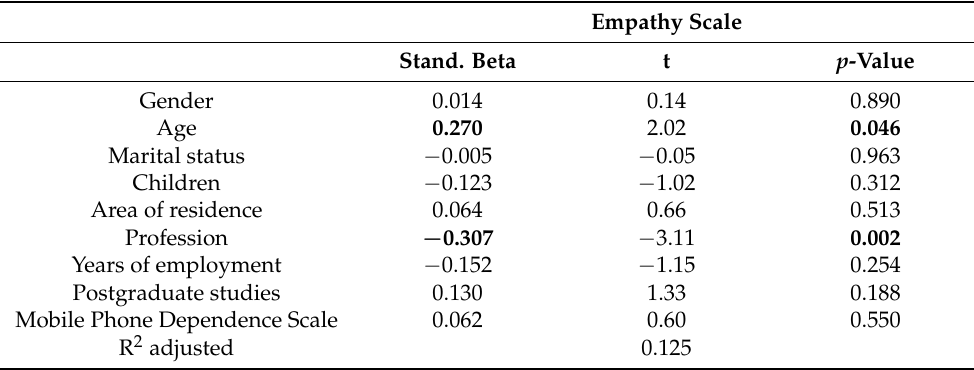
Table 4. Multiple linear regression analysis of empathy scale scores of study participants.